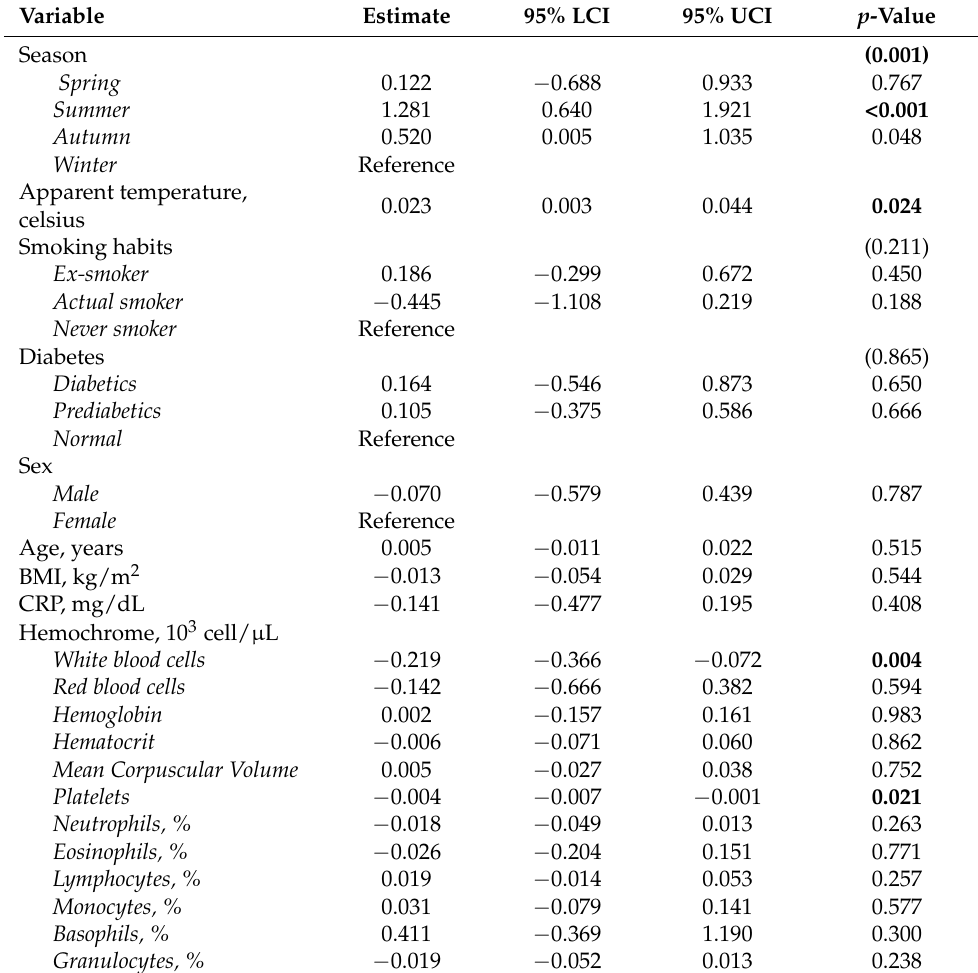
Table 3. Association between potential covariates and DNA adducts in univariate linear regression analysis. Statistically significant results are highlighted in bold character in p -Value column.